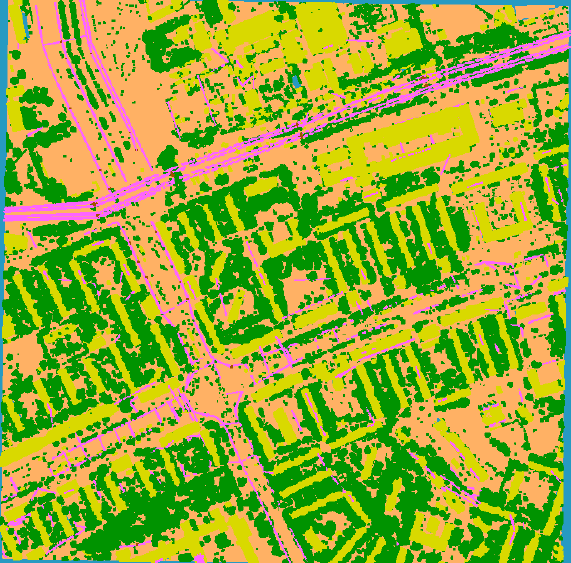
Figure 2. Result of automatic classification by ENVI Lidar